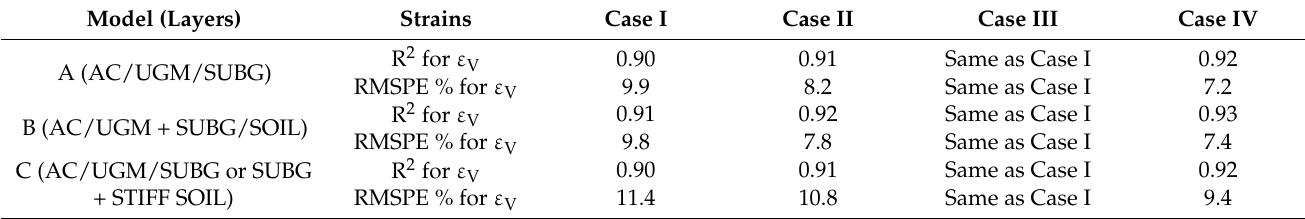
Table 8. Comparison of regression analysis results for three pavement models.